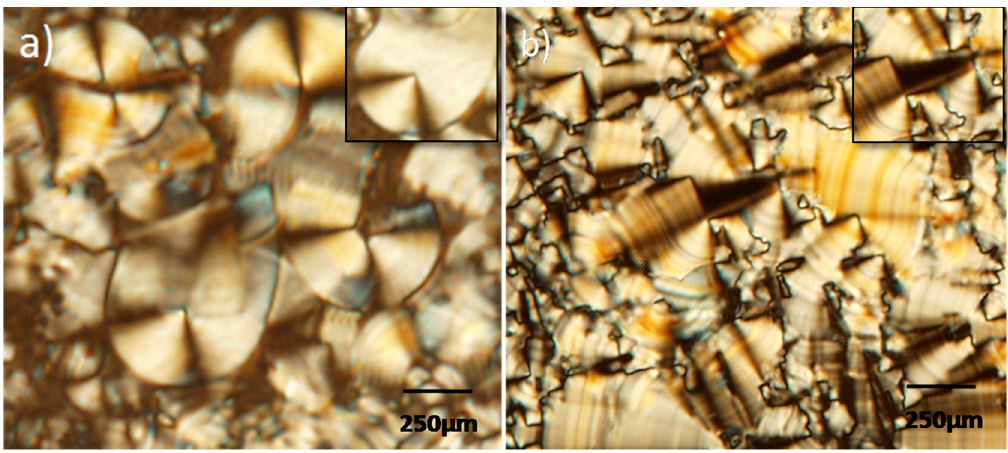
Figure 2. Representative optical polarized micrographs (40×) of the texture exhibited by ( a ) 1 at 158 °C and ( b ) 2 at 106 °C during the cooling.